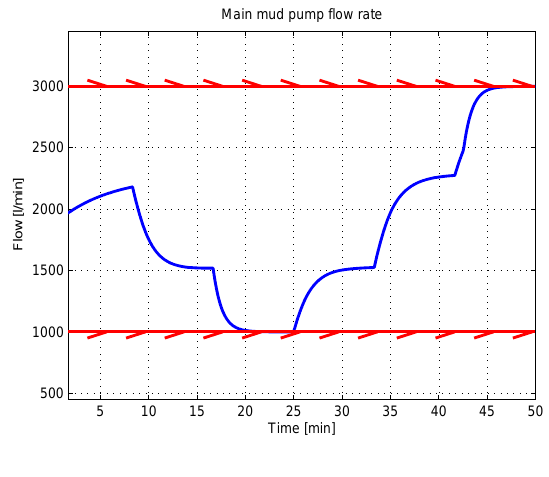
Figure 7: Main mud pump flow rate